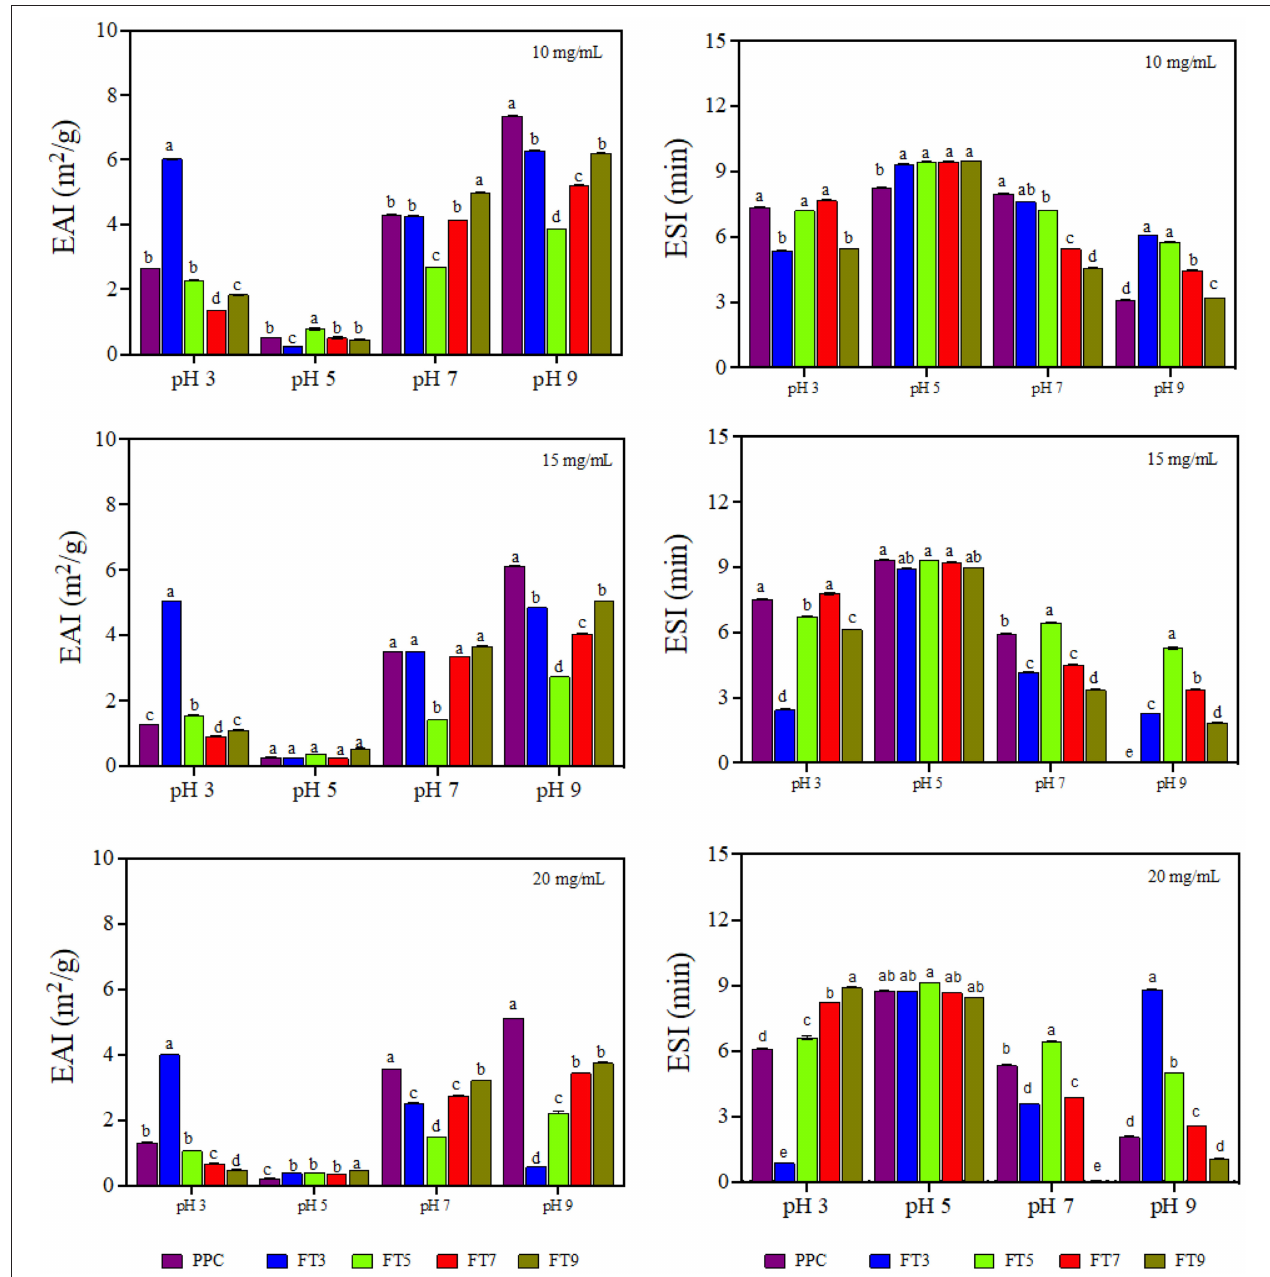
FIGURE 5 | Emulsifying activity index (EAI, m 2 /g) and emulsion stability index (ESI, min) of pea protein concentrate (PPC) and > 50 protein aggregates. PPC was heated at 100 ◦ C and varying pH, centrifuged and the supernatant passed consecutively through 30 and 50 kDa membranes. The final retentate from the 50 kDa membrane was collected as FT3, FT5, FT7, and FT9 for heat treatments at pH 3.0, 5.0, 7.0, and 9.0, respectively. For each plot, bars with different letters have different mean values ( p < 0.05).